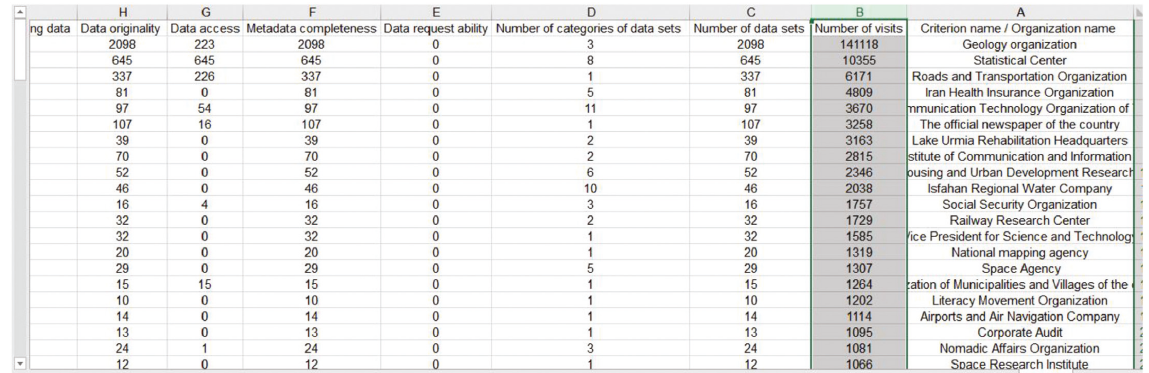
Figure 5: View of the extracted data, the number of visits to each organization, and its data